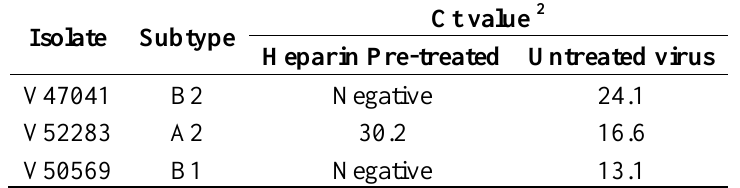
Table 1. Susceptibility of hMPV primary isolates to inhibition of infection by heparin